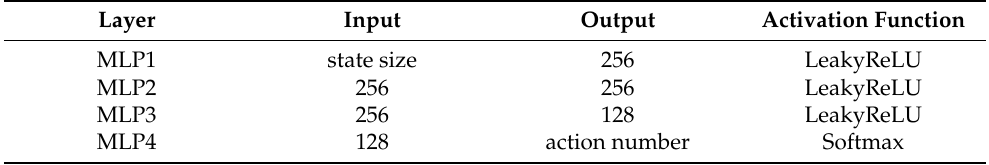
Table 5. SL network